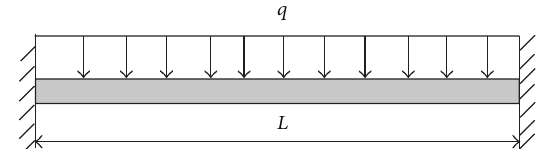
Figure5:TheClampsupportedTimoshenkobeamunderauniform load.